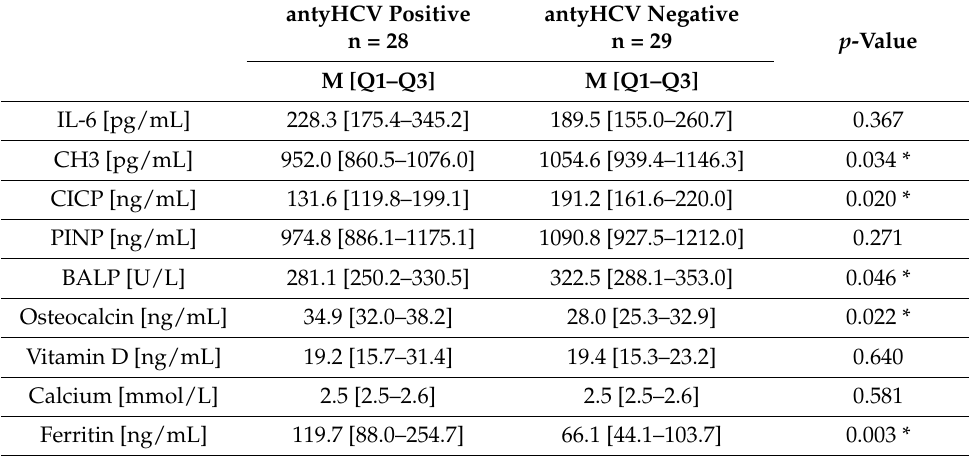
Table 7. Comparison of concentrations of interleukin 6 (IL-6); citrullinated histone CH3 (marker of neutrophil extracellular trap); markers of bone formation (osteocalcin (OT), bone alkaline phosphatase (BALP), N-terminal propeptide of type I procollagen (P1NP)); bone resorption marker-C-terminal telopeptide of type I collagen (C1CP); and vitamin D, ferritin and serum calcium, depending on the presence of anti-HCV antibodies in the serum (reactive or non-reactive result) (median and Q1–Q3). antyHCV Positive antyHCV Negative n = 28 n = 29 p